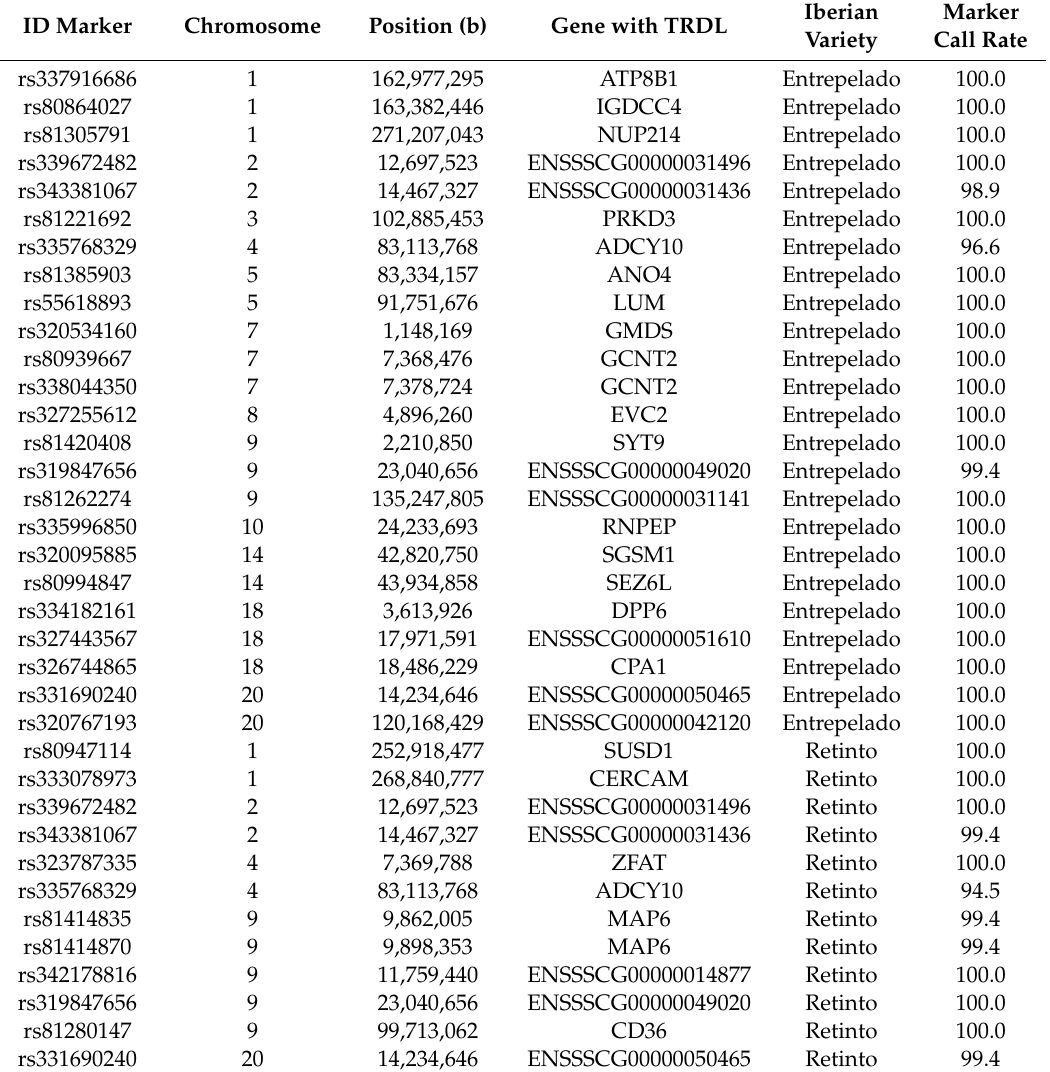
Table 2. Genes with no common maternal transmission ratio distortion loci (TRDLs) detected in both Entrepelado and Retinto varieties.